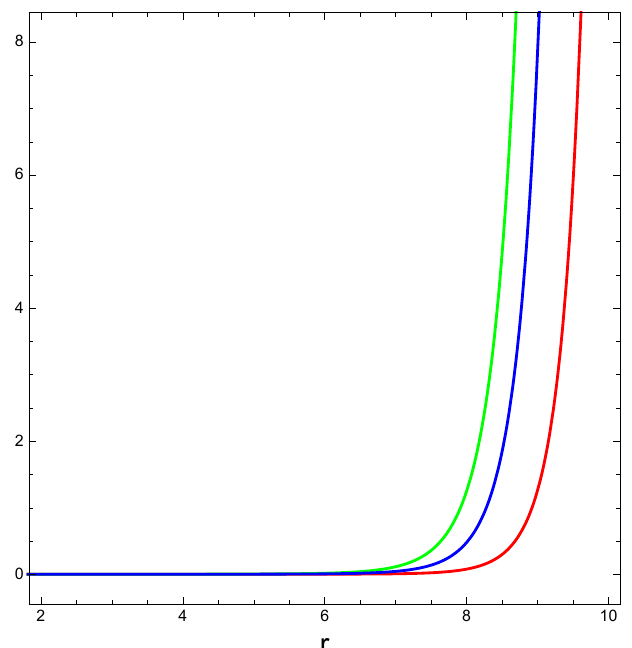
Figure 1. Solution of f ( R ( r )) for R adopted as a quadratic function of radius. The evolution of Equation (7) under f ( R ( r )) gravity is presented. We have fixed the values of η 2 , η 3 , a 0 , a 1 , a 2 , K , and C 1 . The red, green, and blue lines correspond to small perturbations of λ 0 , Ψ 0 , and η 1 , respectively. Solving Equations (19), (11), (14), and (16), we found a solution set of f ( R ( r )) and the corresponding plot for different values of λ 0 , Ψ 0 , η 1 , η 2 , η 3 , a 0 , a 1 , a 2 , K , and C 1 in Figure 2.